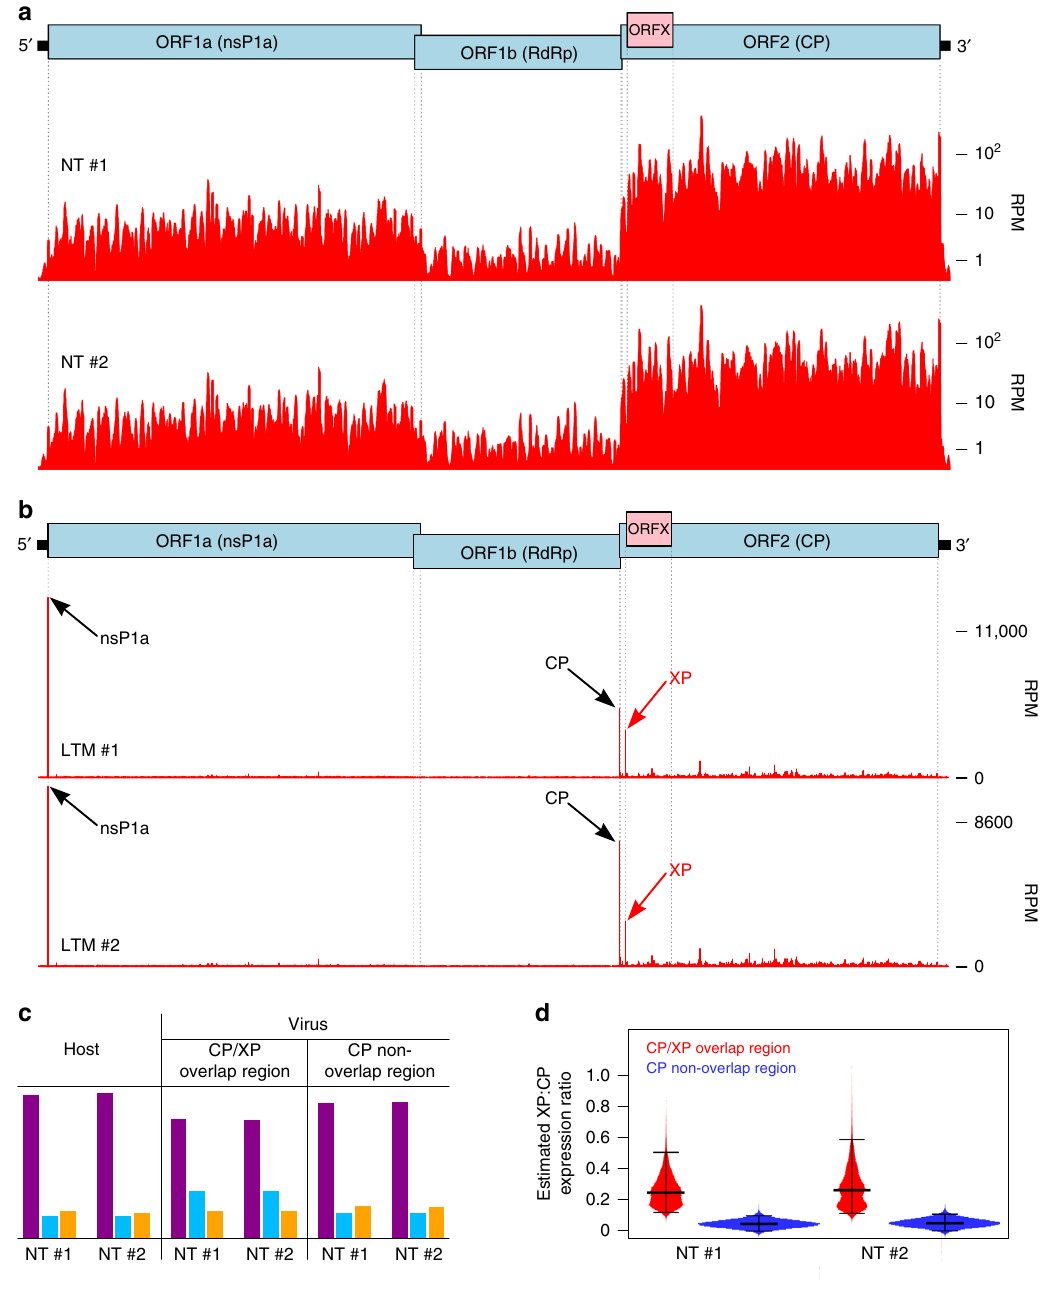
Fig. 2 Ribosome pro fi ling of astrovirus-infected cells. Cells were harvested at 12 hpi and either fl ash frozen with no pre-treatment (NT), or pretreated with lactimidomycin for 30 min followed by fl ash-freezing (LTM). a RPF densities in reads per million mapped reads (RPM) for NT repeats, smoothed with a 15 nt sliding window. b RPF densities in RPM for LTM repeats, at single-nucleotide resolution. c For NT samples, phasing of 5 ′ ends of RPFs that map to host coding sequences, the part of ORF2 that is overlapped by ORFX, and the part of ORF2 that is not overlapped by ORFX. d Distributions of estimated XP- frame:CP-frame expression ratios for 100,000 bootstrap resamplings of codon positions within the overlapping and nonoverlapping regions of ORF2. Black lines show medians and 95% con fi dence intervals. Graphs show the results of two biologically independent experiments (#1 and #2). Source data are provided as a Source Data fi